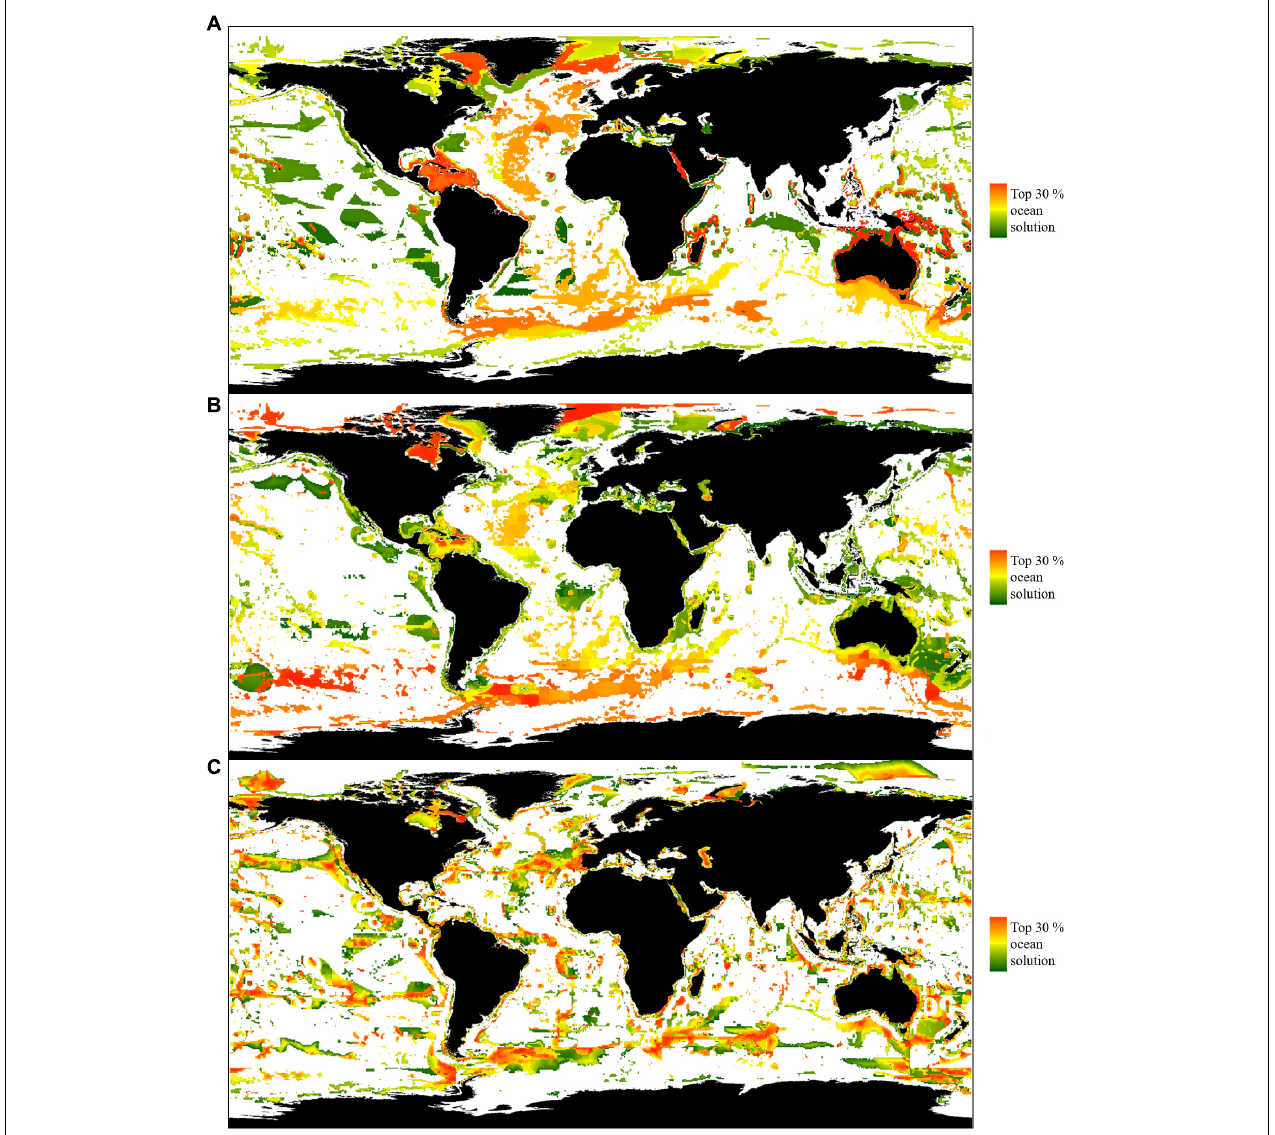
FIGURE 3 | Priority areas for protection covering 30% of the ocean. Colour bars show areas of increasing priority per scenario (green to red), white cells were not selected as priority areas. All displayed priority areas within each scenario were required for protection to achieve any associated benefits. Panel (A–C)